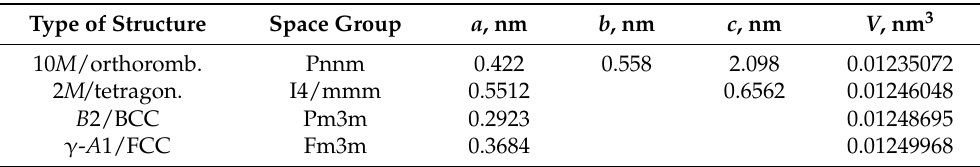
Figure 1. X-ray diffractograms of Ni 50 Mn 28.5 Ga 21.5 alloy ( a ) in the initial cast state; ( b ) after HPC at 3 GPa, ( c ) at 12 GPa; after HPT at 5 GPa at ( d ) 2 and at ( e , f ) five revolutions. The observations were performed at ( a – e ) RT and ( f ) 130 K. Table 1. Type, crystal structure parameters ( a , b , c ), and specific atomic volume ( V ) of phases in the alloy Ni 50 Mn 28.5 Ga